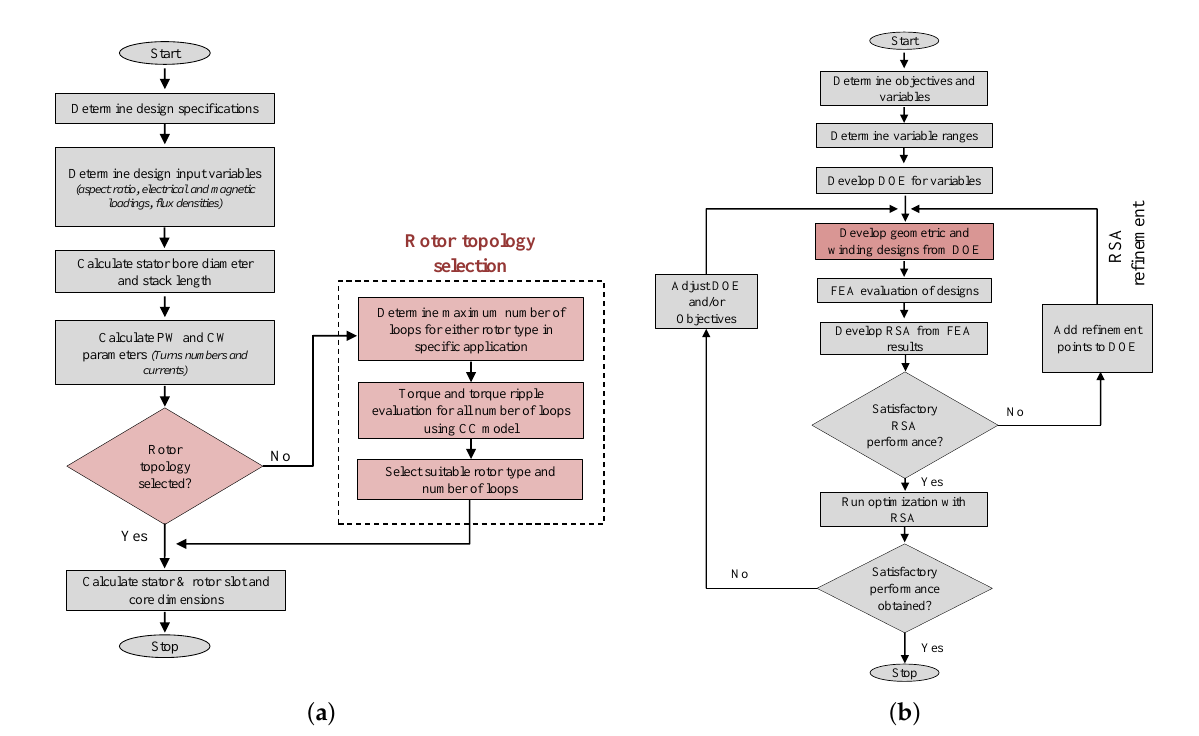
Figure 15. Design process proposed by authors: ( a ) Geometric and winding design process and ( b ) optimization process. Table 3. Summary of design and optimization